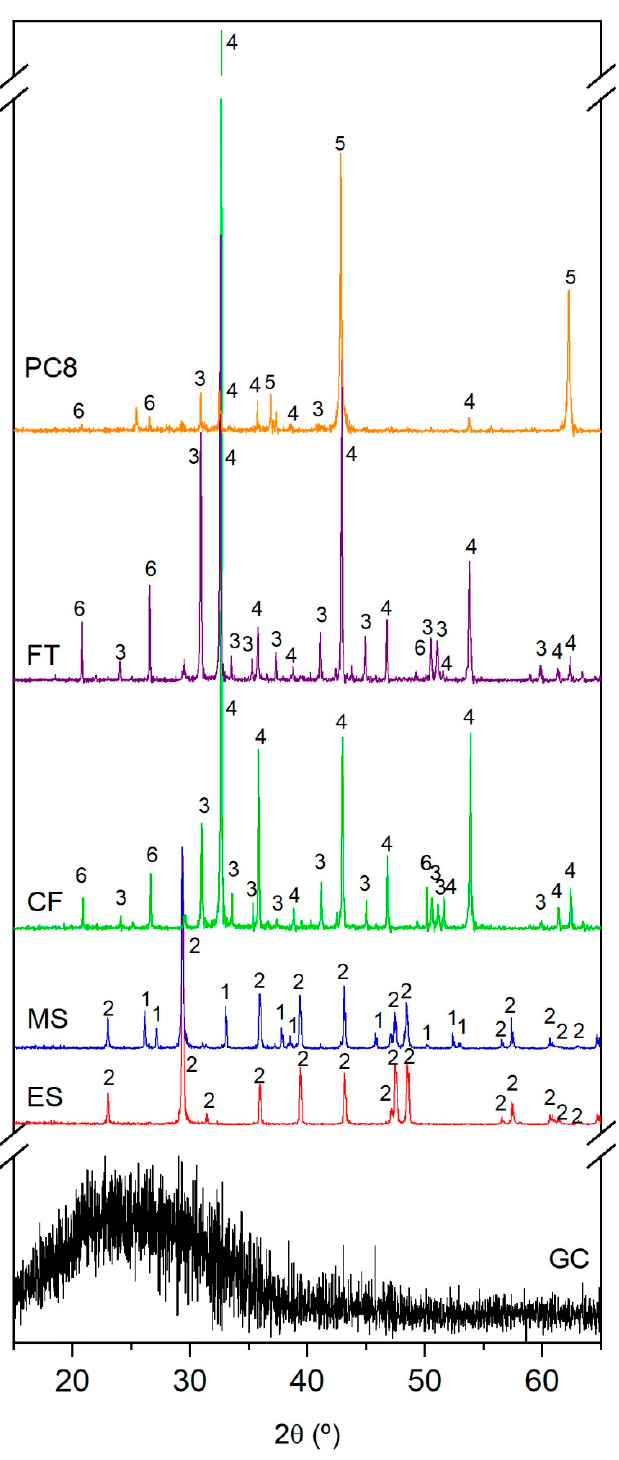
Figure 1. XRD patterns of raw materials: glass cullet (GC), eggshell (ES), mussel shell (MS), carbonate F (CF), flotation tailing (FT) and carbonate PC8 (PC8). (1: aragonite (CaCO 3 ), 2: calcite (CaCO 3 ), 3: dolomite (CaMg(CO 3 ) 2 ), 4: magnesite (MgCO 3 ), 5: periclase (MgO) and 6: quartz (SiO 2 )). Regarding the thermal behavior, the DTA curve of the glass cullet shows a glass tran- sition temperature, T g , at approximately 610 °C (Figure 2). The density, hardness and ri- gidity decrease from T g , and the glass is turned into a viscous plastic state that is suitable